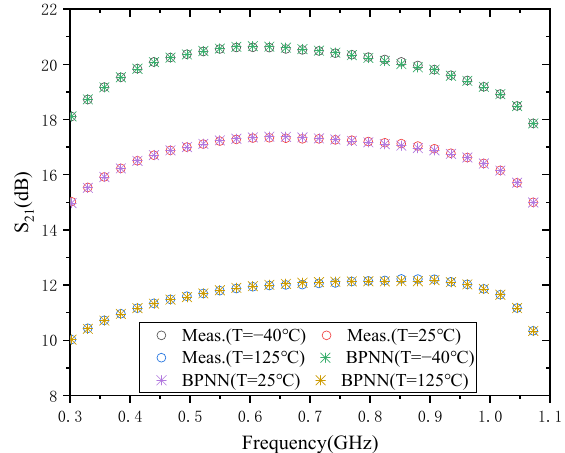
Figure 4. Modeling results of S 12 .